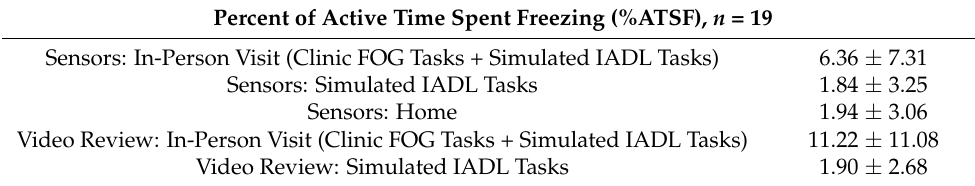
Table 3. Percent of Active Time Spent Freezing (%ATSF), n =